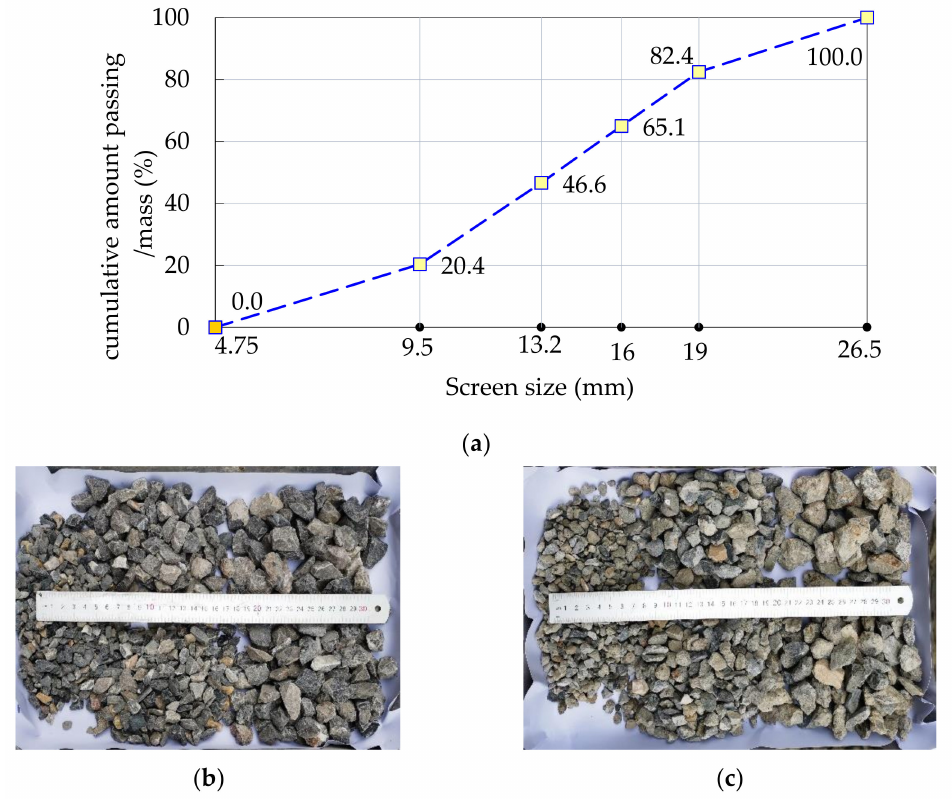
Figure 1. Screening and composing gradation of coarse aggregates for: ( a ) the grading curve of natural coarse aggregate used; ( b ) the appearance of natural coarse aggregates with continuous gradation; and ( c ) the appearance of coarse recycled concrete aggregates with continuous